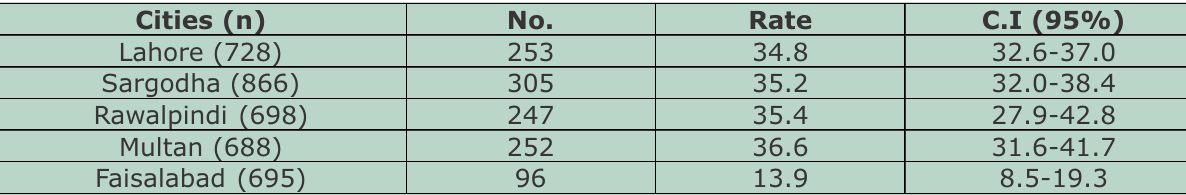
Table- I: Prevalence of disability according to Cities.